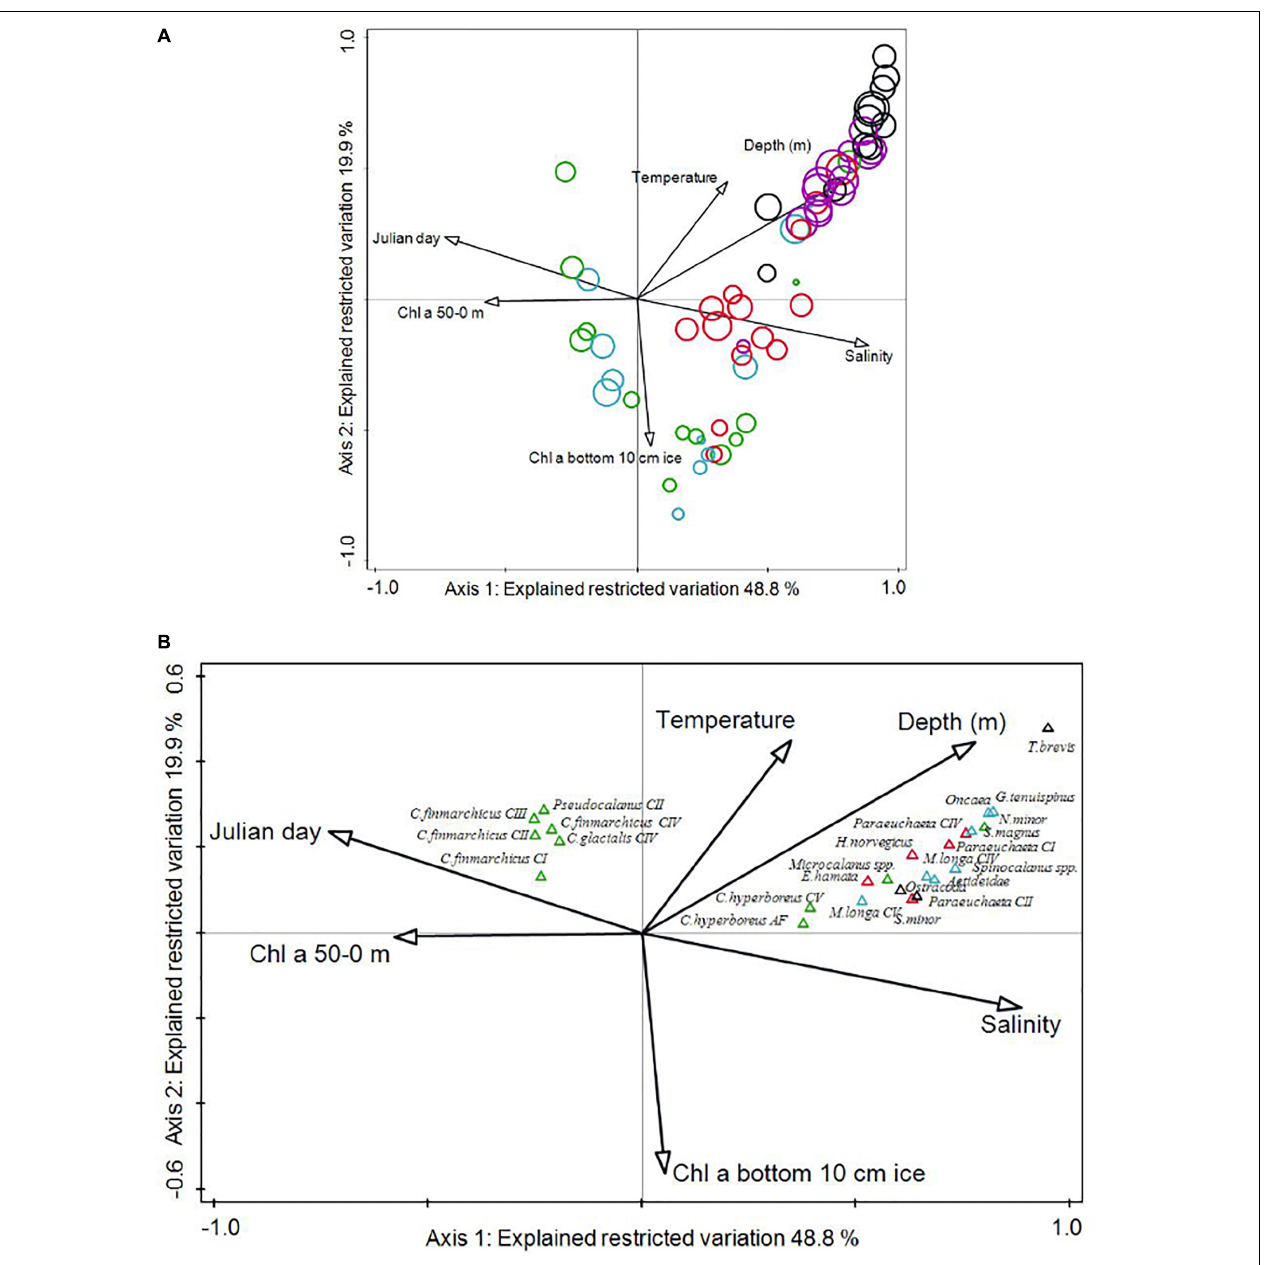
FIGURE 5 | CCA biplots of (A) samples of mesozooplankton abundance (coloured circles) and environmental variables (arrows) and (B) species and environmental variables (arrows). Environmental variables are listed in Table 4 . The first canonical axis explains 49% of the variation explained by the selected environmental variables. The second axis explains 20% of the variation explained by the selected environmental variables. In panel (A) , the size of the sample circles reflects the count of species within the sample, the greater the size the higher species diversity within that sample. Samples from different depth layers are in different colours. The different colours of the species in panel (B) indicate the predominant trophic level of that species; herbivores are marked in green, carnivores in red and omnivores in blue and undefined in black. For simplicity reasons, only the 25 species with the largest fit value to the axis are shown. Some of the species’ names are given as abbreviations, the full names are given in Supplementary Table 2